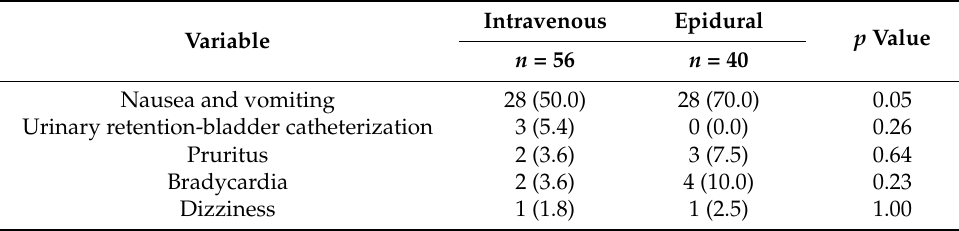
Table 5. Side effects of postoperative